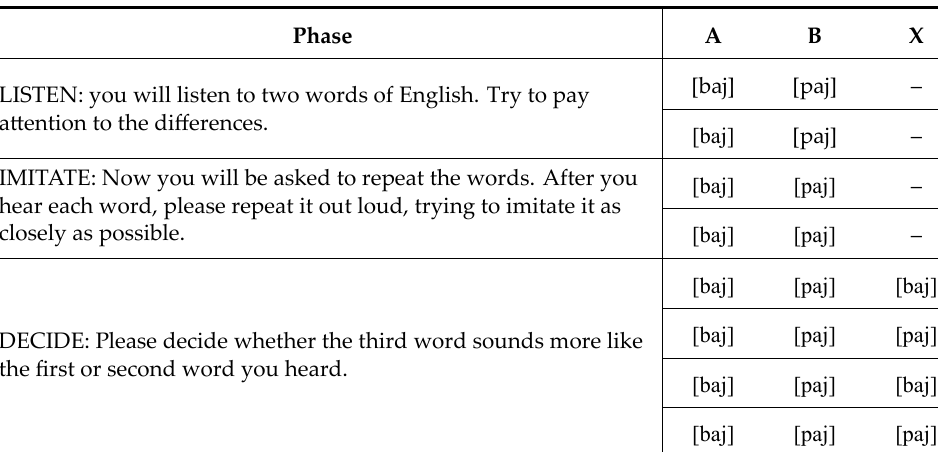
Table 4. Summary of a sample trial set from the English block. Phase A B